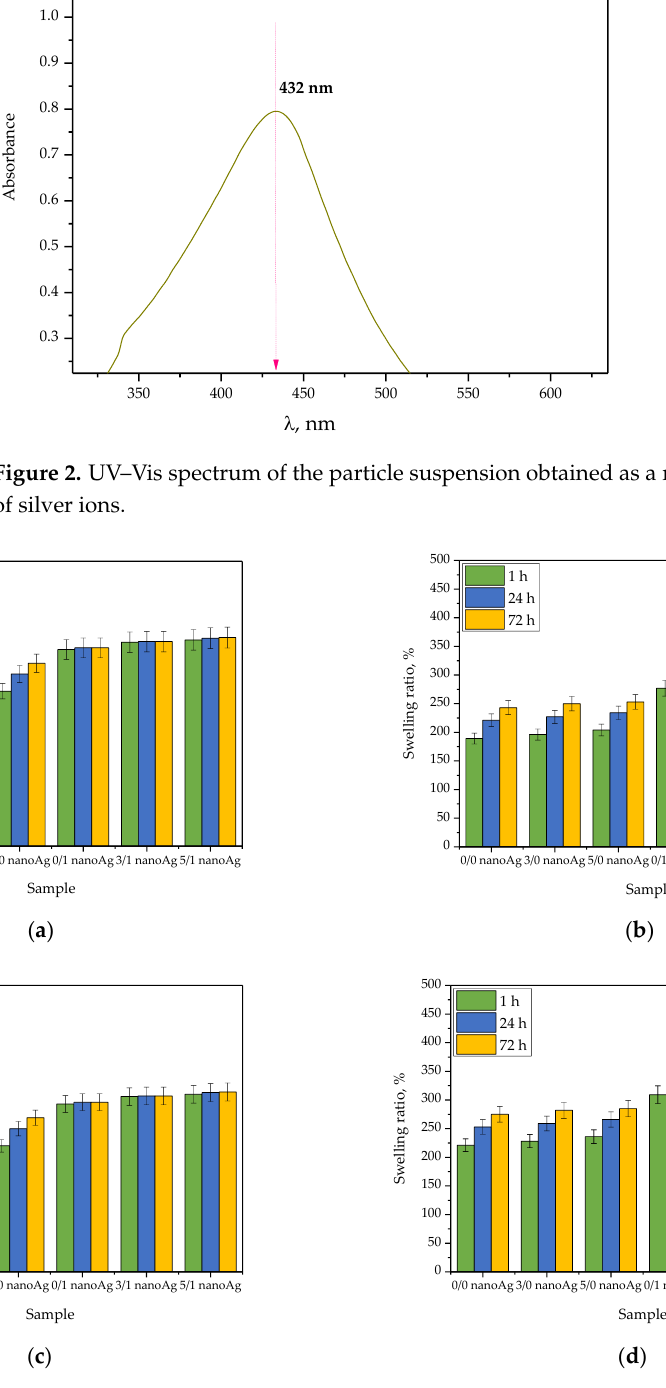
Figure 2. UV – Vis spectrum of the particle suspension obtained as a result of the chemical reduction of silver ions.